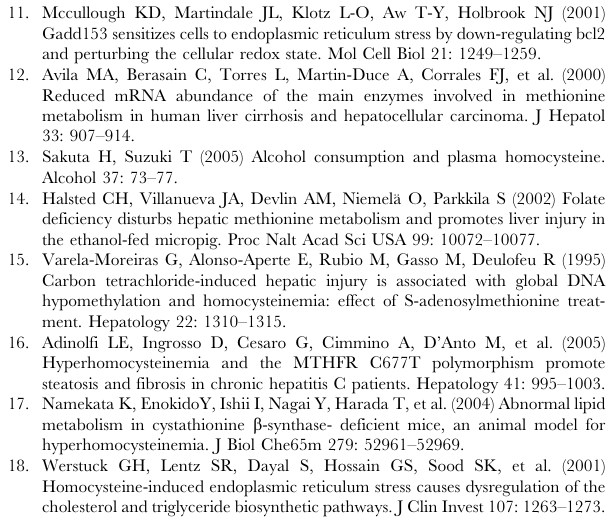
Figure S2 Knockdown of p53 restores the inhibitory effect of homocysteine on cell proliferation. HepG2 cells were transfected with control siRNA and siRNA-p53. After incubated with 1 mM of homocysteine (Hcy) for 24 h, the cellular proliferation was assessed by [ 3 H]-thymidine incorporation into DNA. These results are means 6 SD of three experiments. a P , 0.05 versus control (without Hcy); b P , 0.05 versus Hcy. Table S1 The primers for real-time